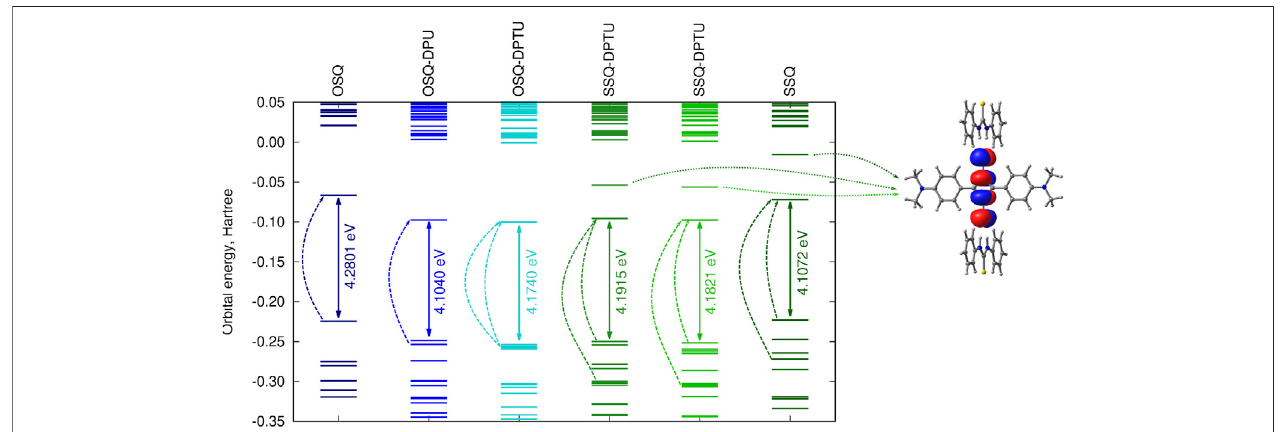
FIGURE10| Orbitalenergylevels[CAM-B3LYP/6-31+G(d)]fortheinvestigatedunsubstitutedsystemstogetherwiththeLUMO+1orbitalforthiosquaraine(dashed lines indicate the orbitals involved in the most intensive one-photon singlet – singlet transitions; for the corresponding orbital shapes compare Figure 12 ).